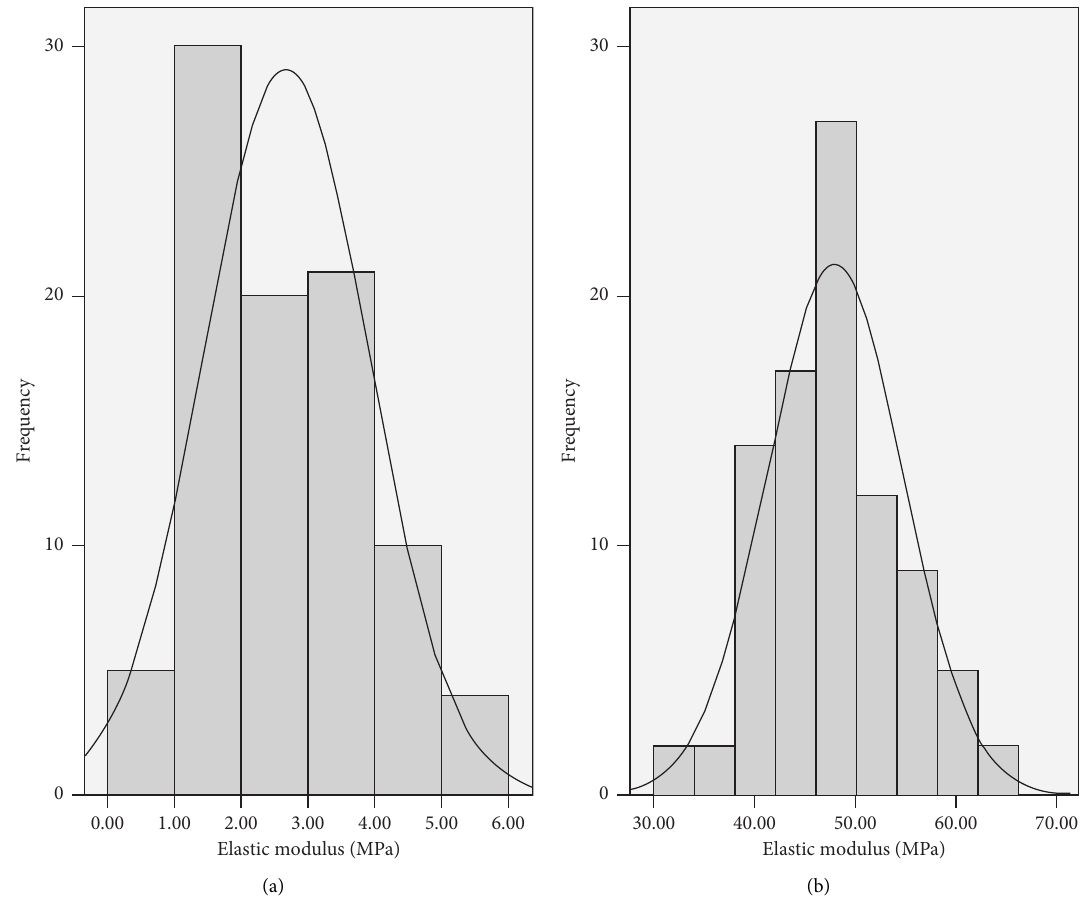
Figure 4: Frequency distribution histogram of LSTM (a) and HSTM (b). Table 3: Correlation coefficient of corneal biomechanical parameters and relevant influencing parameters.